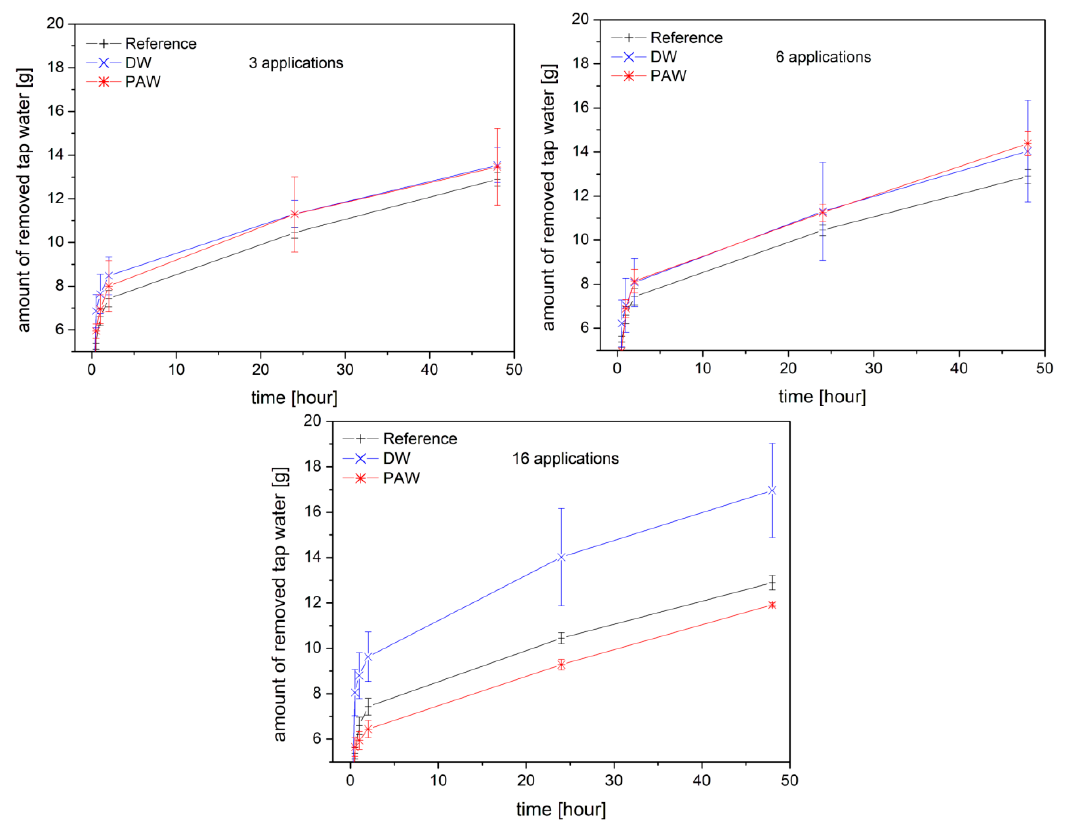
Figure 7. Removal of tap water in dependence on the number of DW/PAW applications.